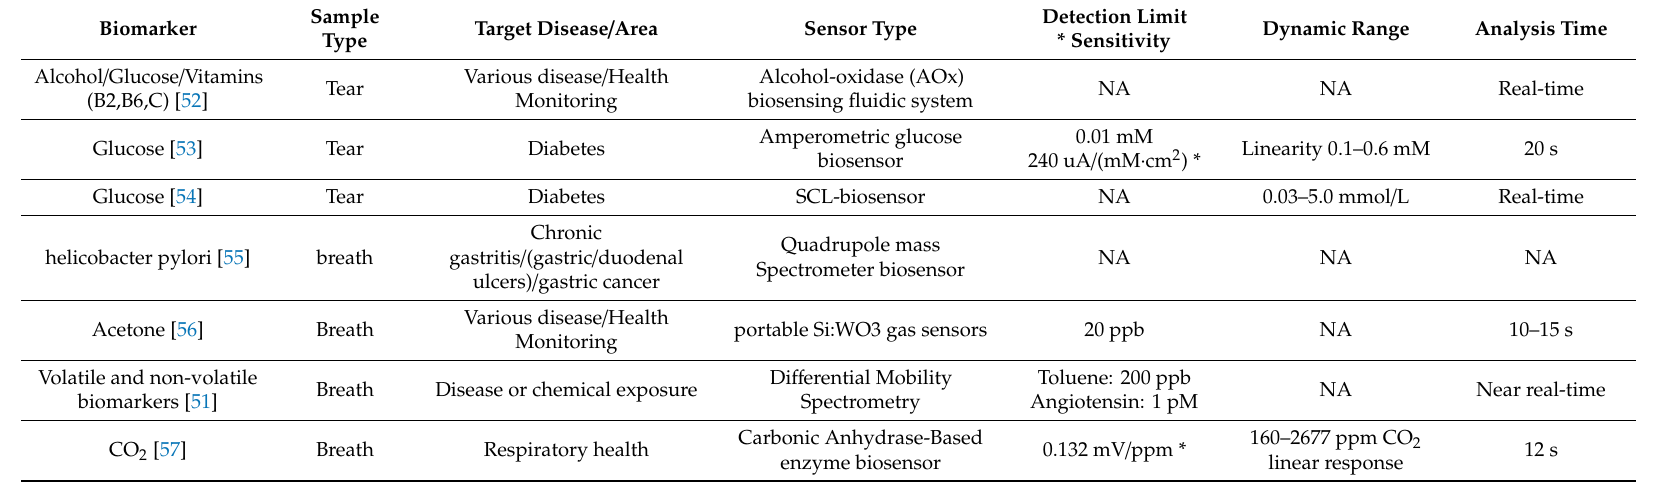
Table 5. Summary of Portable Biosensors for Tears / Breath Biomarker